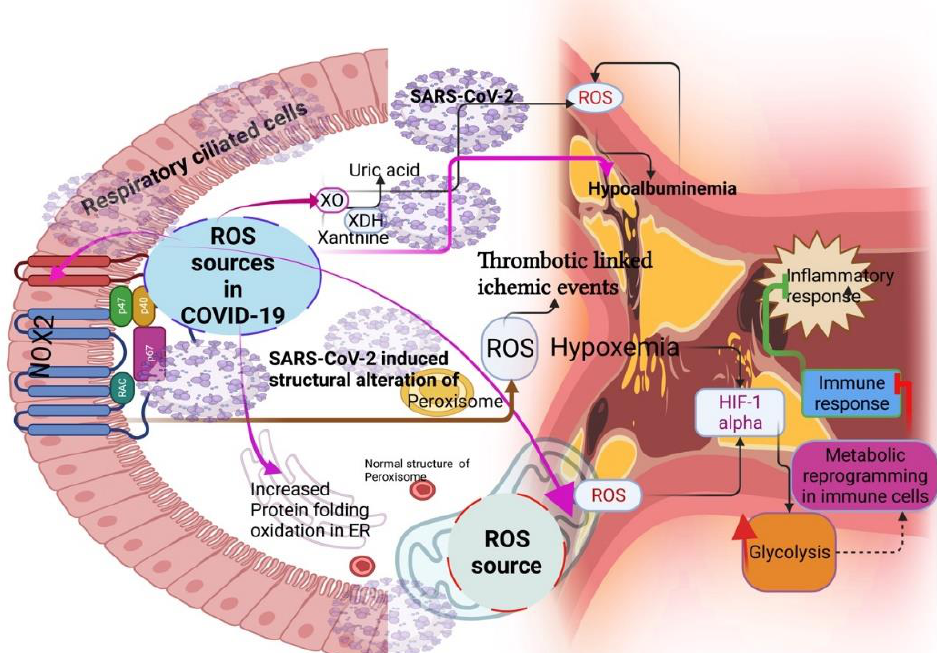
Figure 2. Sources of ROS during COVID-19 (pink arrow mark). NOX2-induced ROS increases the thrombotic-linked ischemic events in COVID-19. Mitochondrial-triggered ROS reprogram the metabolism for inhibiting immune response through hypoxia-inducible-1 alpha factor (HIF-1 alpha). SARS-CoV-2 altered the peroxisome morphology, consequently increasing ROS generation.